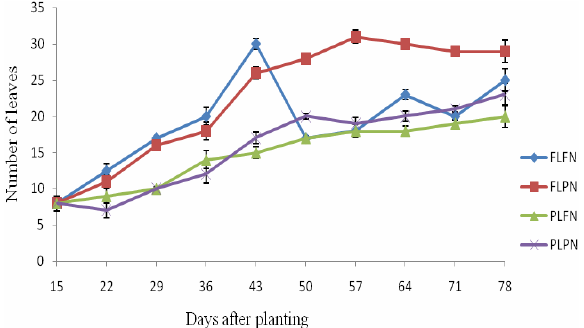
Fig. 2. Effect of light and nutrient stress on the number of leaves